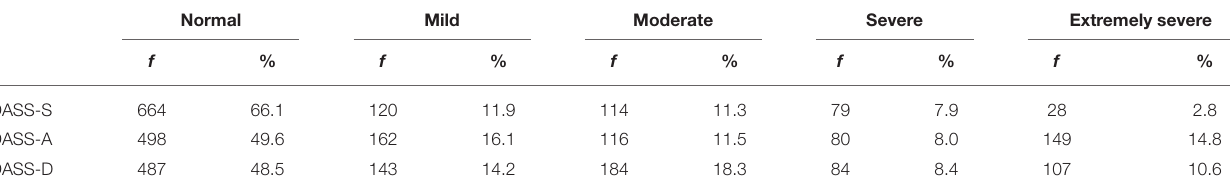
TABLE 2 | Stress, anxiety and depression symptoms severity categorization ( N = 1,005). Normal Mild Moderate Severe Extremely severe